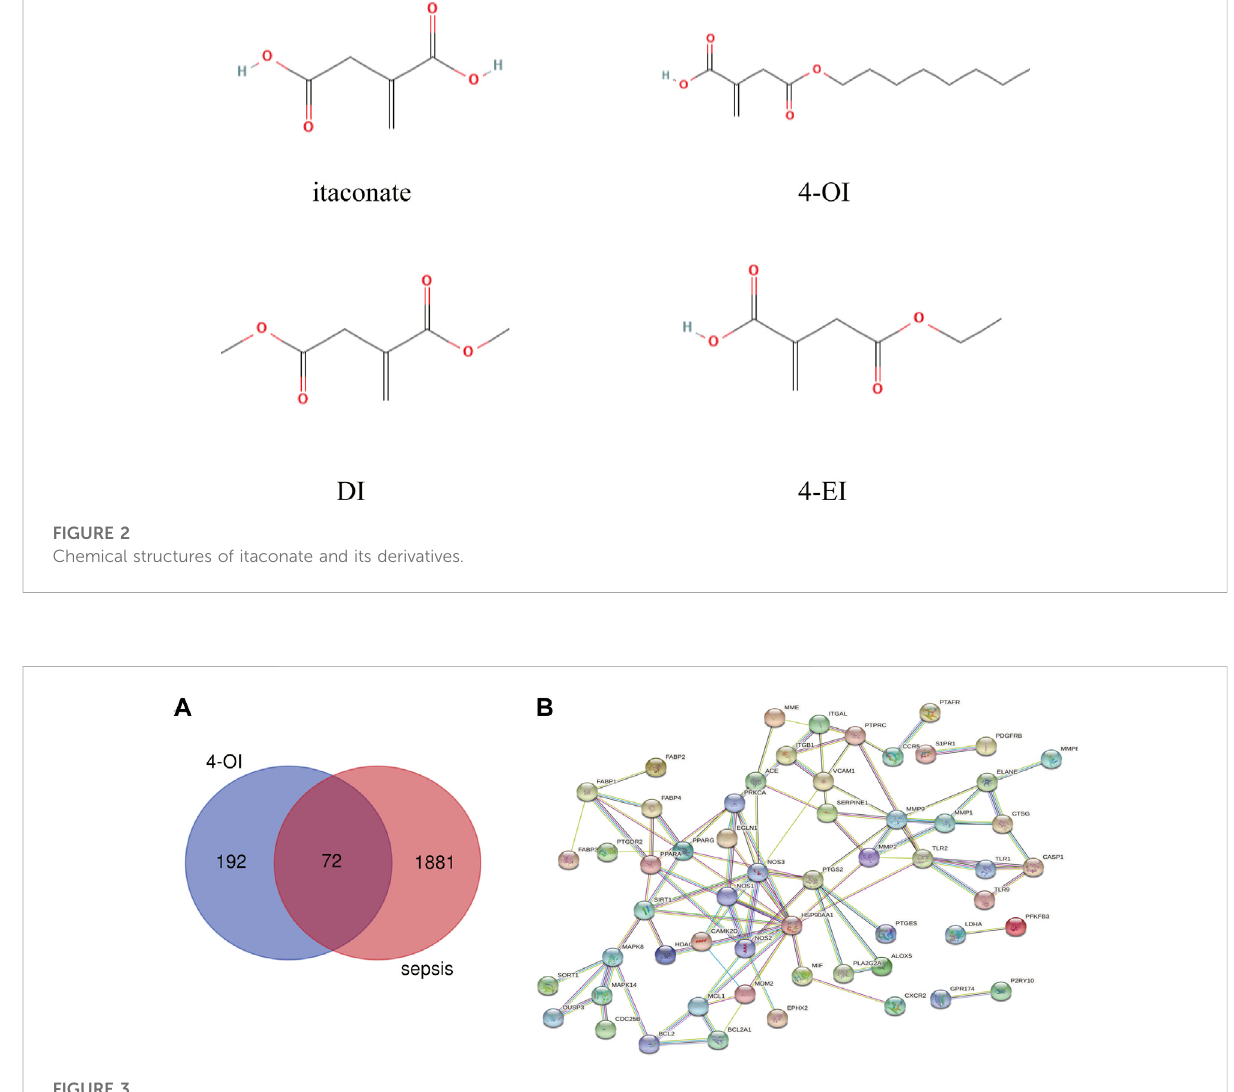
FIGURE 3 VenndiagramandPPInetworkweredrawnforall4-OIantiseptictargets. (A) TheVenndiagramidenti fi edatotalof72crossovertargets. (B) The PPI cross-target network is constructed using Cytoscape software, and the interaction score is set to a high con fi dence level of